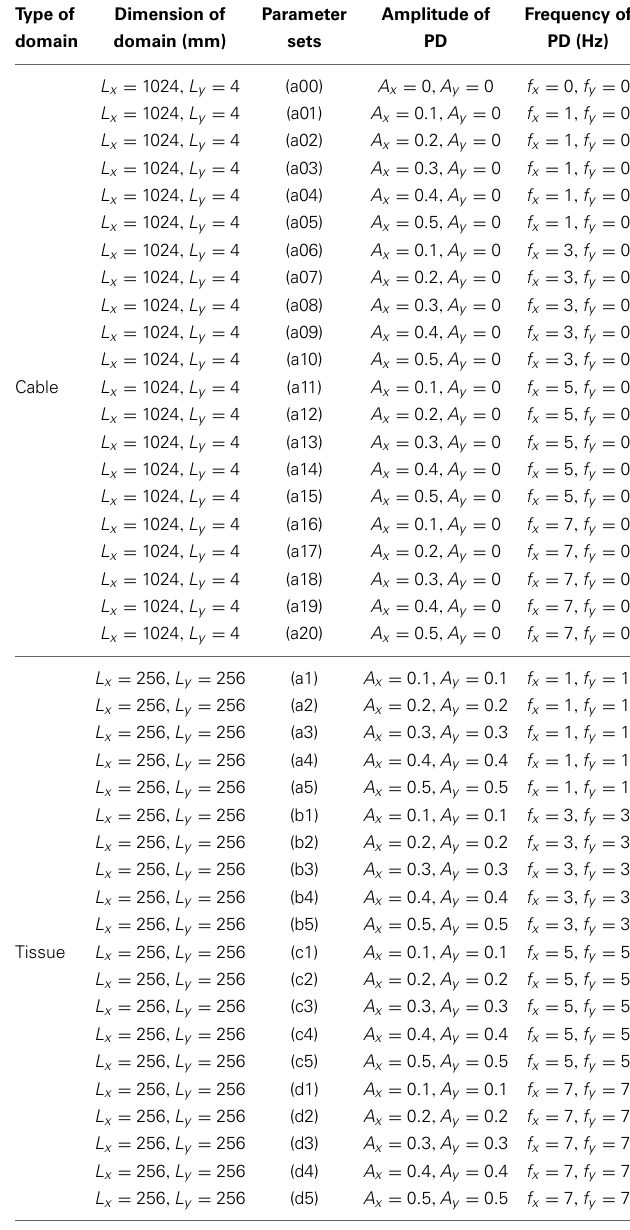
Table 1 | Parameters for the periodic deformation (PD) that we use to study the wave dynamics in our cable-type and square simulation domains in both TP06 and TNNP04 ventricular